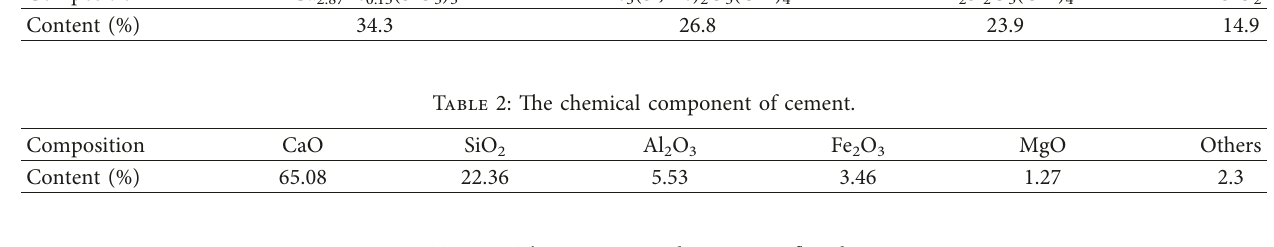
Table 3: The main mineral content in fly ash.